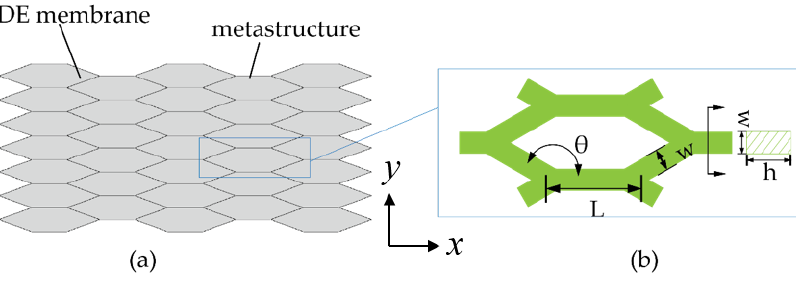
Figure 4. The CAD model in ABAQUS: ( a ) assembly of the DE membrane and honeycombs; ( b ) the geometry parameters of each honeycomb